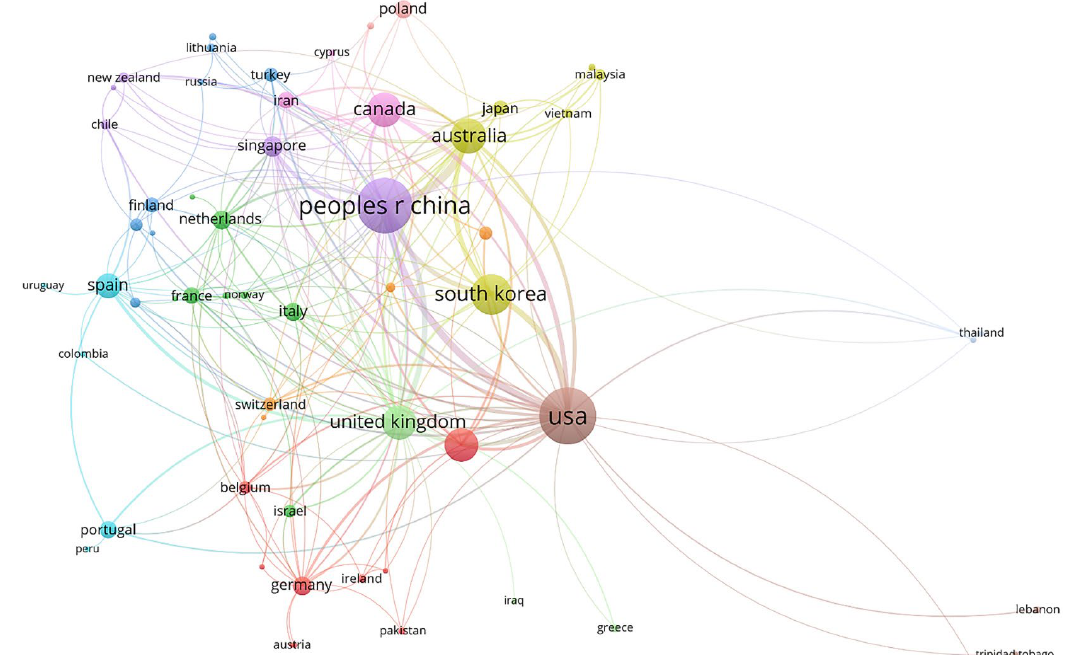
Figure 4. The country/region co-authorship